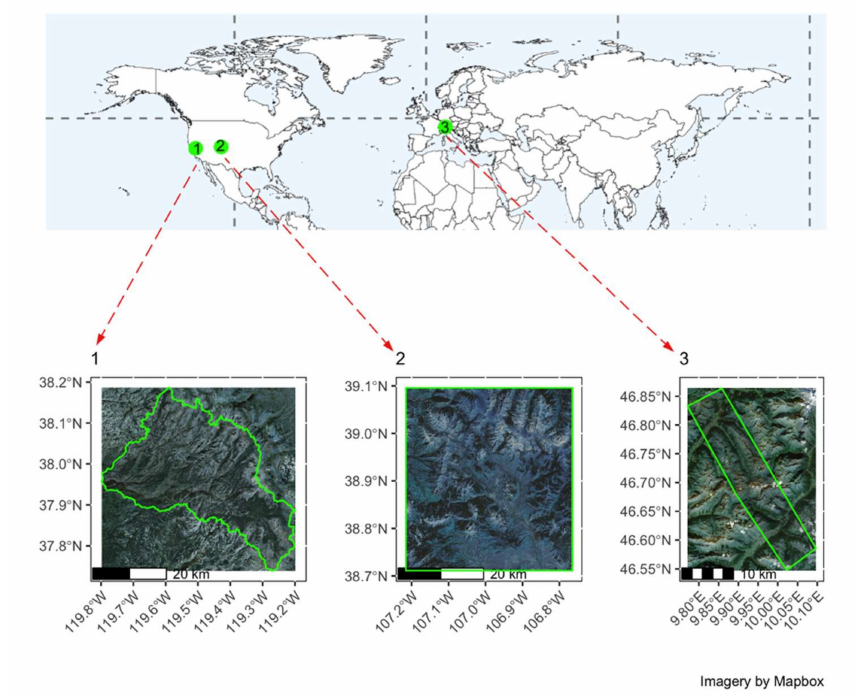
Figure 1. Study sites—( 1 ) Upper Tuolumne (37.89 ◦ N, − 119.25 ◦ W, California, USA), ( 2 ) Upper Gunnison (39.08 ◦ N, − 107.14 ◦ W, Colorado, USA), and ( 3 ) a site near Engadin, Switzerland (46.58 ◦ N, 10.03 ◦ W,